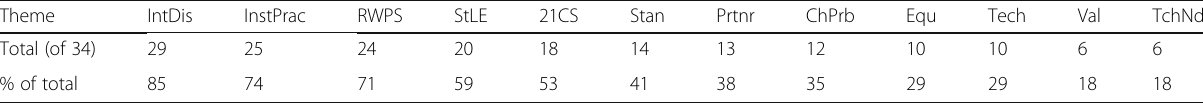
Table 3 Total number and percentage of participants who included each theme on concept maps or interview Theme IntDis